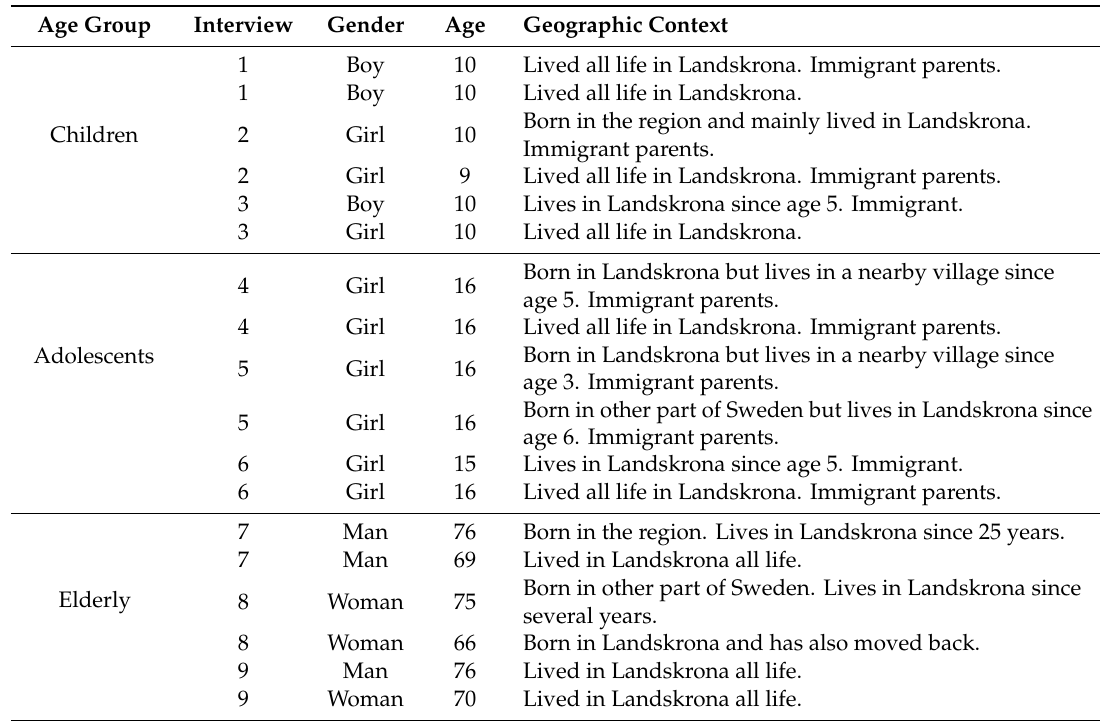
Table 1. Information about the respondents in the